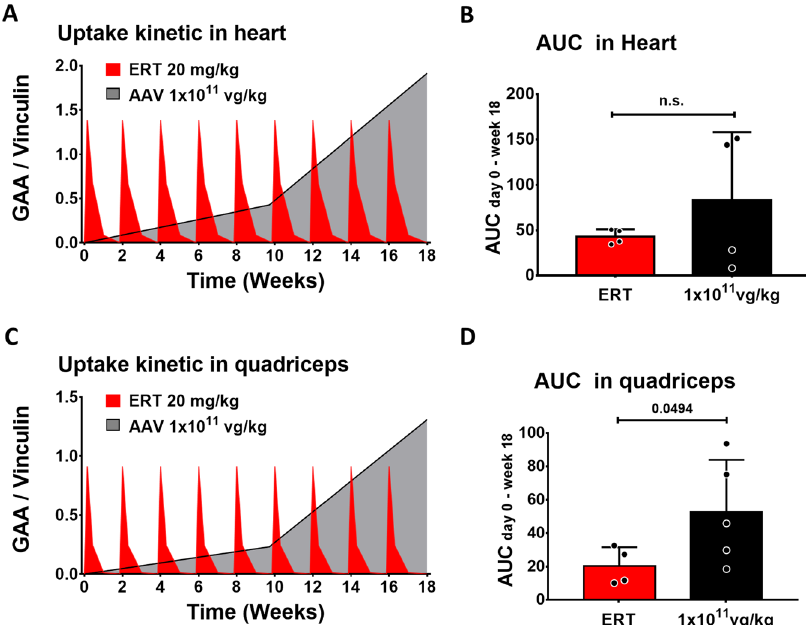
Fig. 7 Hepatic gene transfer provides superior bioavailability of GAA in refractory tissues compared to enzyme replacement therapy (ERT). A Representation of GAA kinetics in heart measured by quanti fi cation of lysosomal GAA enzyme over time by Western blot. B Analysis of the area under the curve (AUC) between time 0 (day − 1) and week 18 in heart (ERT, n = 4; AAV-GAA, n = 4). C Representation of GAA kinetics in quadriceps (ERT, n = 4; AAV-GAA, n = 5). D Analysis of the area under the curve (AUC) in quadriceps. Data shown as average ± SD. Statistical analysis: t -test; n.s. non-signi fi